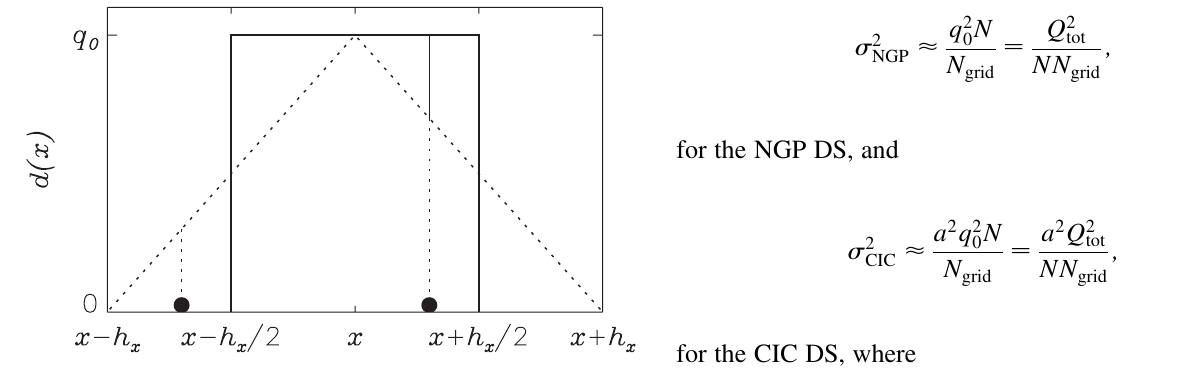
(cid:2) x (cid:3) (solid line) and d (cid:2) x (cid:3) FIG. 6. Deposition functions d NGP CIC (dashed line) in 1D. x denotes the location of a particle whose charge is to be deposited. The NGP DS affects only the nearest grid point to which it deposits all of its charge. The CIC DS affects the two closest grid points in each coordinate, as dis- cussed in the text. Filled circles represent grid